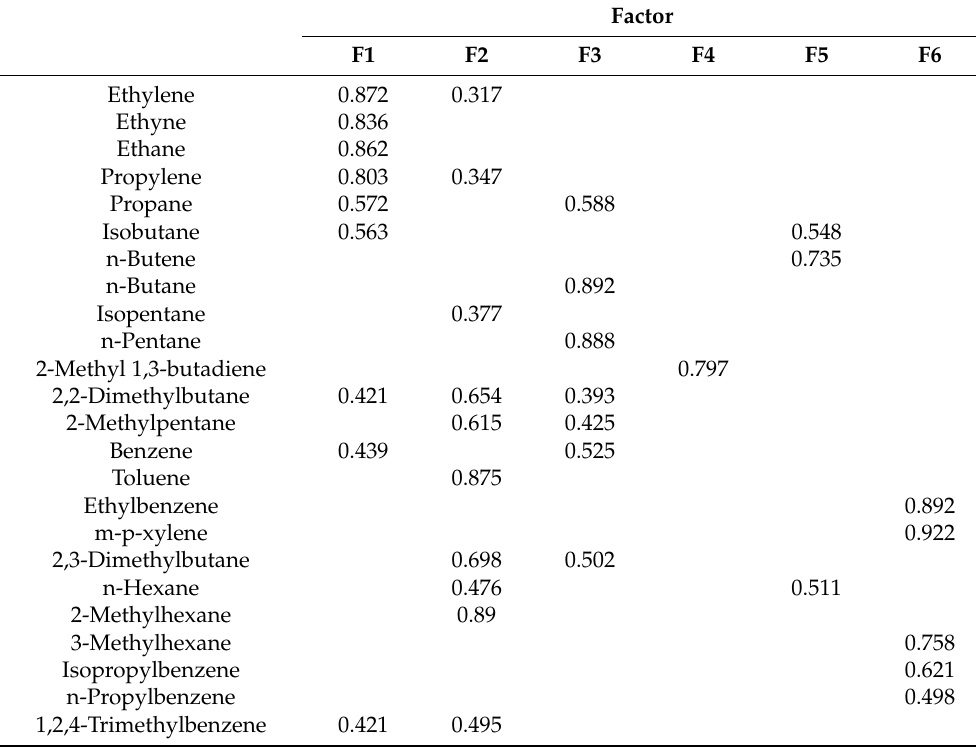
Table 2. PCA results for 24 VOCs at the Changzhi Environmental Monitoring